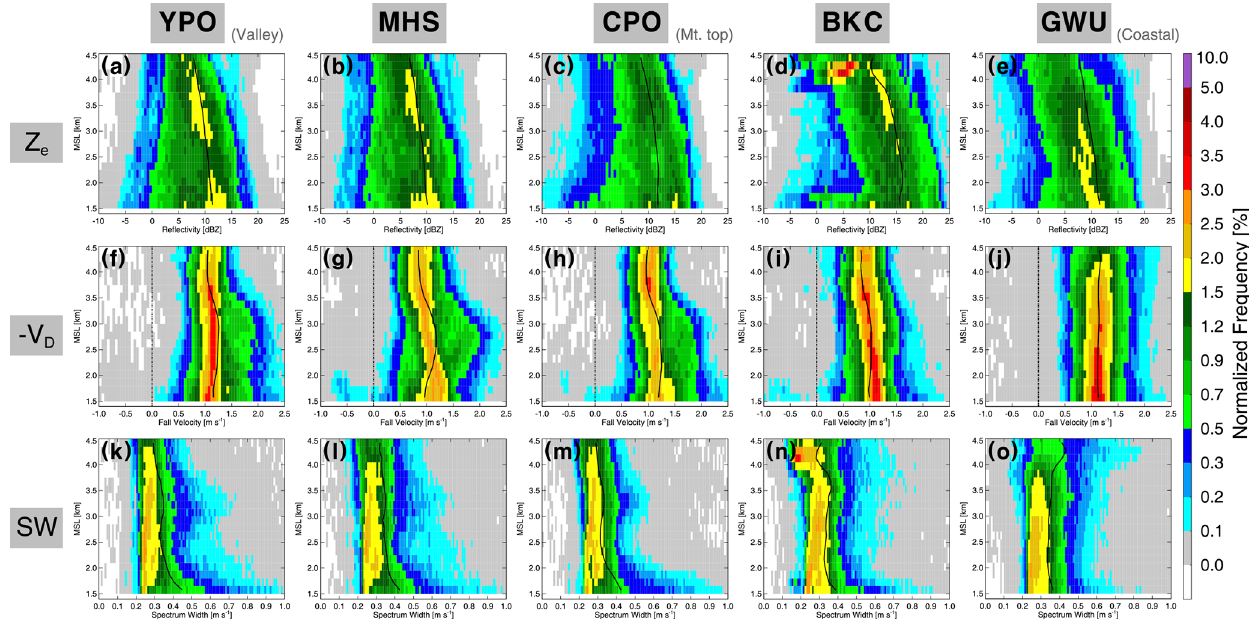
Figure 4. CFADs of radar reflectivity (dBZ; a–e ), negative of Doppler radial velocity (ms − 1 ; f–j ), and spectral width (ms − 1 ; k–o ) from MRR for 2017–2018 winter at (a, f, k) YPO at the valley, (b, g, l) MHS, (c, h, m) CPO at the mountain top, (d, i, n) BKC, and (e, j, o) GWU sites at the coastal region. The solid line indicates the average value for each diagram. Dash-dotted lines represent 0.0ms − 1 in Doppler velocity. The mean liquid-equivalent precipitation rate from the Z e –SR relationship at 24.23GHz (Souverijns et al., 2017) at 1.5km height is 0.79, 0.61, 0.86, 1.91, and 0.84mmh − 1 for YPO, MHS, CPO, BKC, and GWU, respectively.